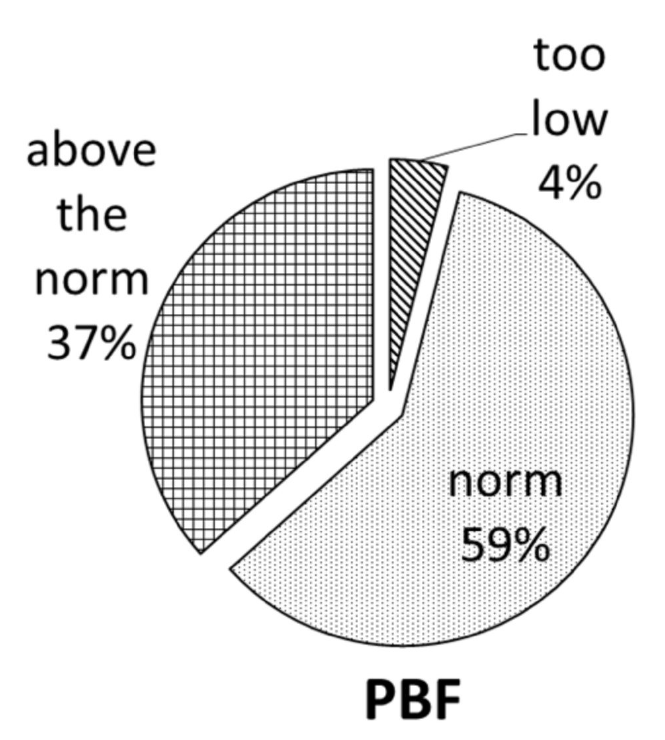
Figure 2. Percentage of women with normal BMI depending on percent body fat